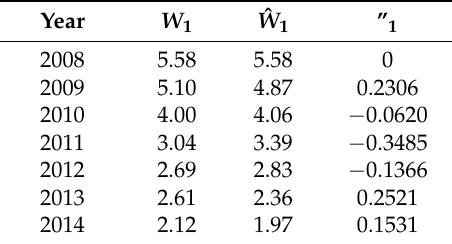
Table 3. Simulation results of W 1 .